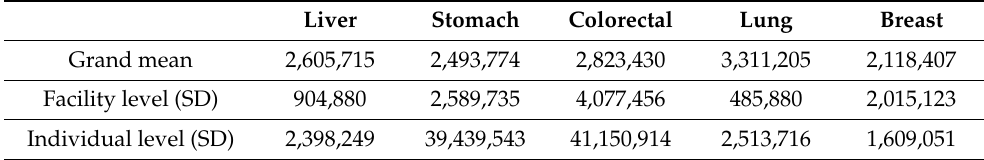
Table 5. Statistical variance of cancer care cost using mixed